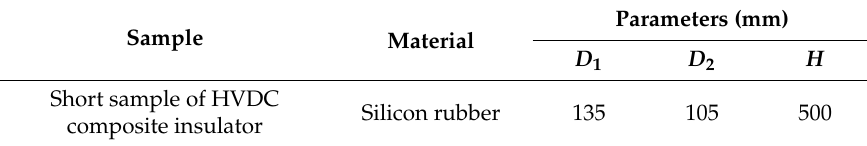
Figure 1. Short samples of High Voltage Direct Current (HVDC) composite insulators. Table 1. Structure parameters of the tested